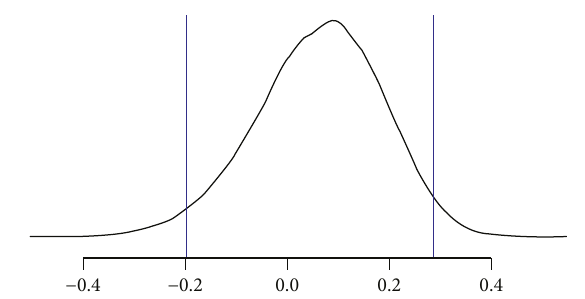
Figure 1: Posterior probability distribution of the mean di ff erence between the proportion of occurrence of a second tumor and the proportion of occurrence of a third tumor in our patient population. The vertical lines are drawn at the boundaries of the central 95% region of the posterior di ff